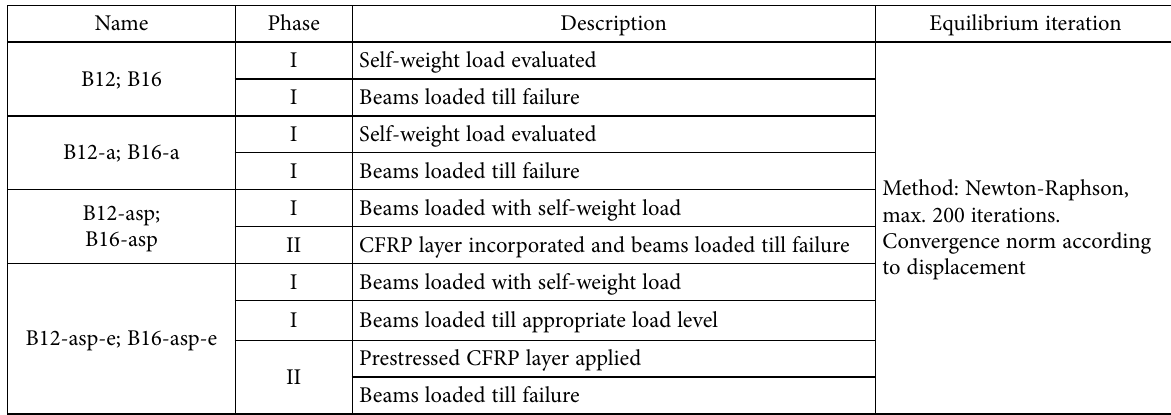
Table 4. Steps and description of numerical